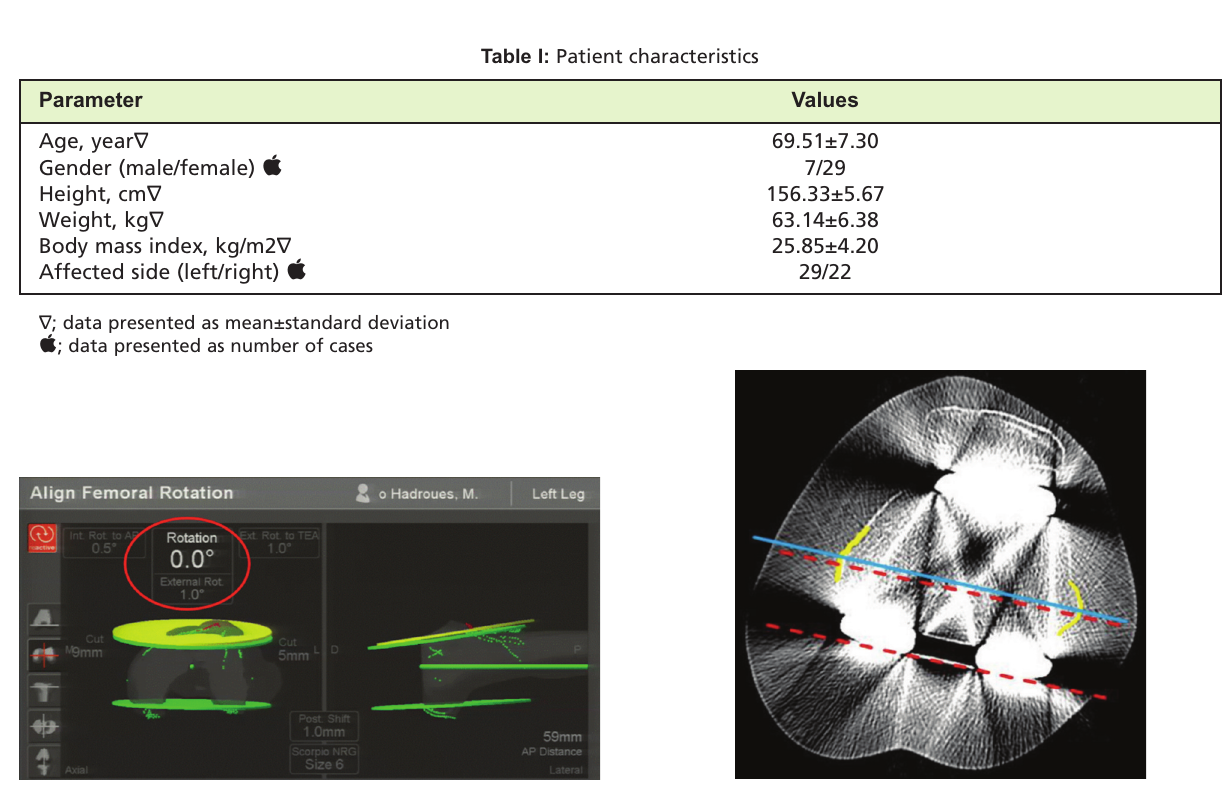
Computed tomographic image showing the Fig. 2: measurement of the post-operative femoral component rotation (CT-FRA). The CT-FRA is the angle between the transepicondylar axis (blue line) and the posterior condylar axis of the femoral component (red dashed